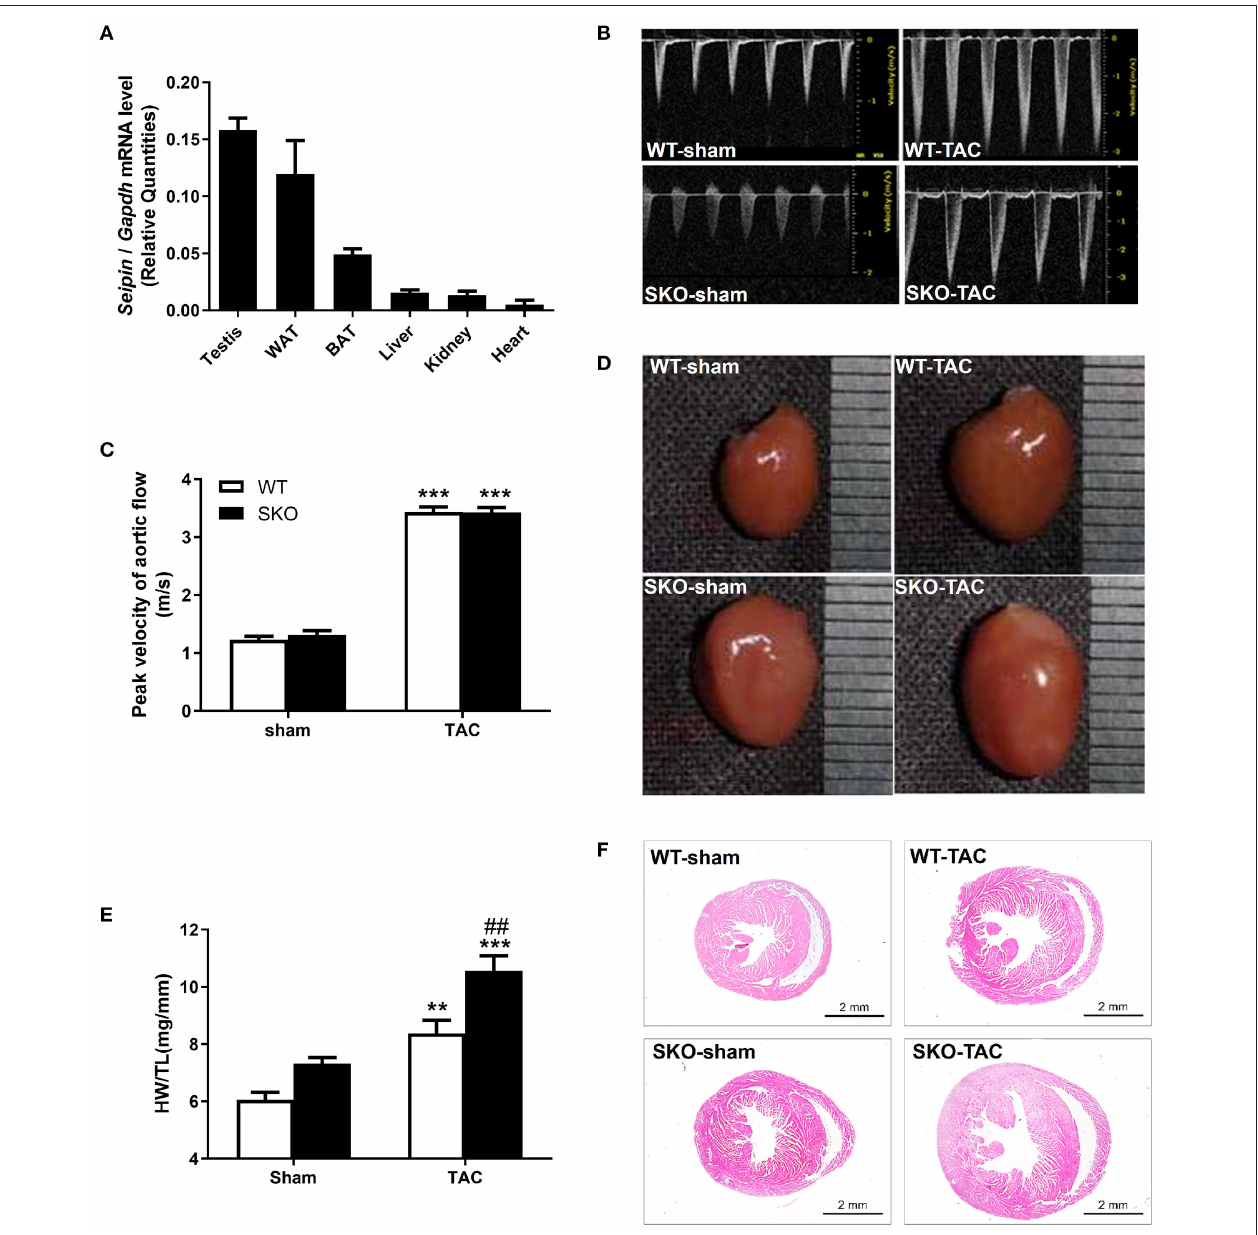
FIGURE 1 | Seipin mRNA expression in WT mice and Seipin gene deficiency promoted myocardial hypertrophy at 12 weeks after TAC. (A) Seipin mRNA expression levels in different tissues in 6-month-old C57BL/6 WT male mice; (B) Blood flow spectrum of the aorta; (C) Peak values of the blood flow velocity; (D) Representative photographs of the heart; (E) Ratio of heart weight/tibia length (HW/TL); (F) Hematoxylin–eosin staining of longitudinal sections of the heart. ** P < 0.01, *** P < 0.001, effect of TAC; ## P < 0.01, effect of genotype. WAT, white adipose tissue; BAT, brown adipose tissue. WT, Wild-type; SKO, Seipin knockout; TAC, transverse aortic